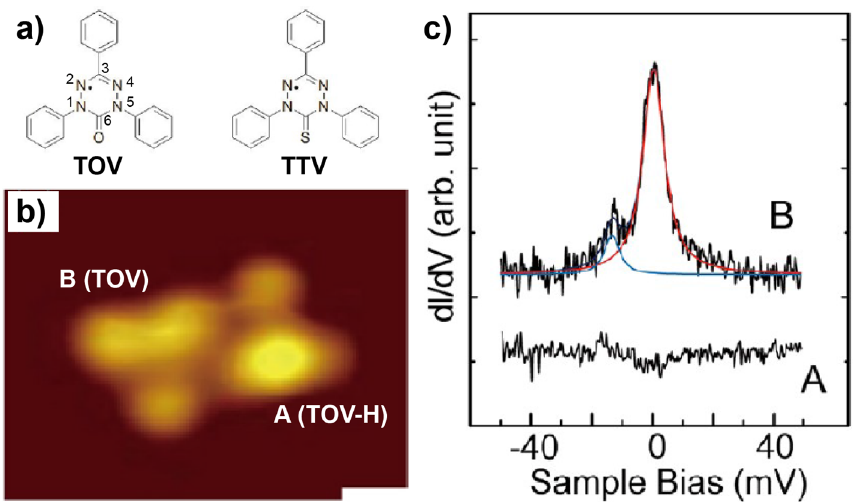
Figure 1. ( a ) Chemical structures of 1,3,5-triphenyl-6-oxoverdazyl (TOV) and 1,3,5-triphenyl-6-thioxoverdazyl (TTV). ( b ) Scanning tunneling microscopy (STM) image of the TOV molecules of types A and B on Au(111). ( c ) Differential conductance (d I /d V ) spectra recorded at TOV molecules of types A and B. Adapted from [44] with permission from The American Chemical Society, 2013.